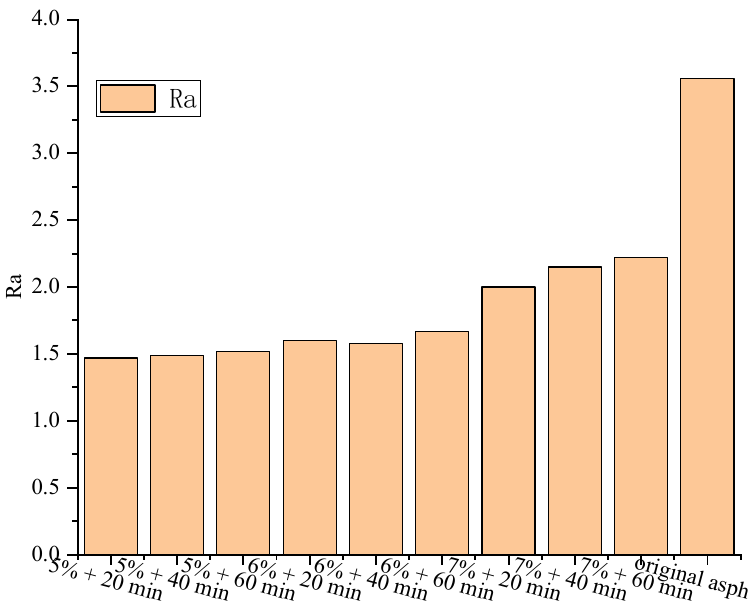
Figure 7. Ra value of contour arithmetic of aging asphalt after regeneration.